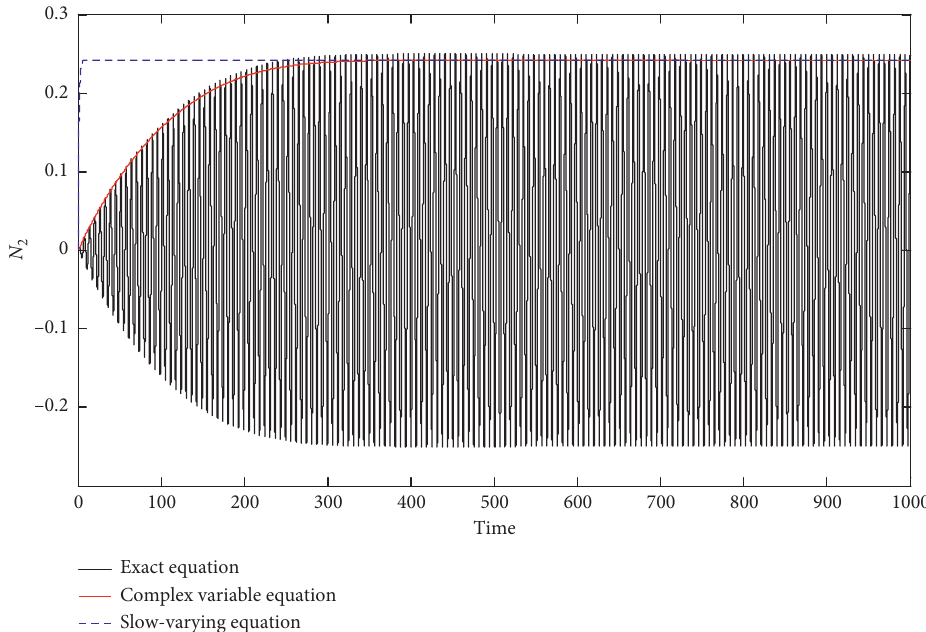
� 0 . 8 ; λ � 0 . 3 ; kn � 5 ; f � 0 . 25. 1 2